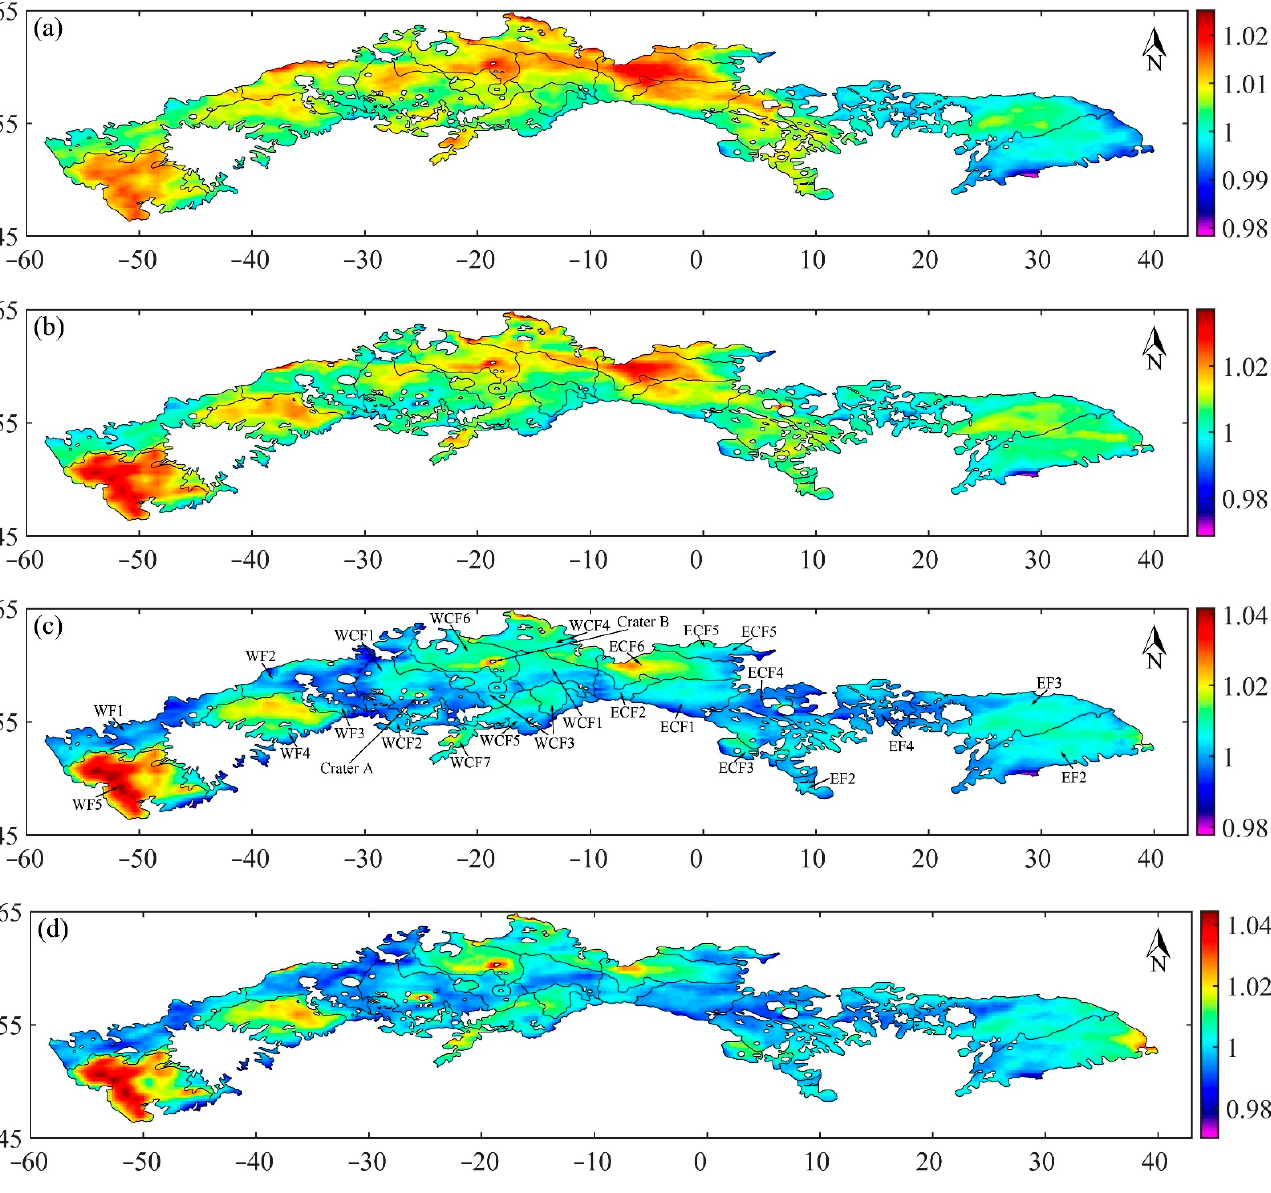
Figure 5. Normalized TB maps of Mare Frigoris at night: ( a ) 3.0 GHz, ( b ) 7.8 GHz, ( c ) 19.35 GHz, and ( d ) 37 GHz (equidistant cylindrical projection). The black lines are the geologic boundaries of Mare Frigoris mapped by Kramer et al. [2]. Crater A and Crater B are two craters with TB anomalies, as discussed in Sections 3.2.2 and 4.2.1.